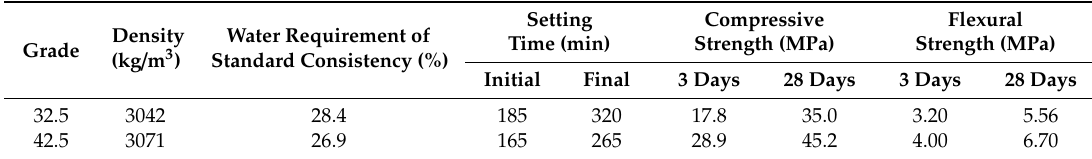
Table 1. Physical and mechanical properties of cement.